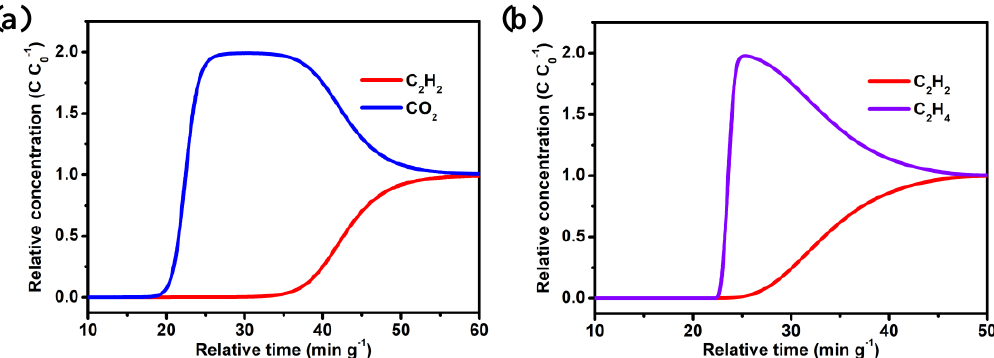
Figure 4. The column breakthrough curves for mixture gases of ( a ) C 2 H 2 /CO 2 (50:50, v / v ), and ( b ) C 2 H 2 /C 2 H 4 (50:50, v / v ). The experiments were conducted at 298 K and the inlet gas flow rate was maintained at 2 mL min − 1 .